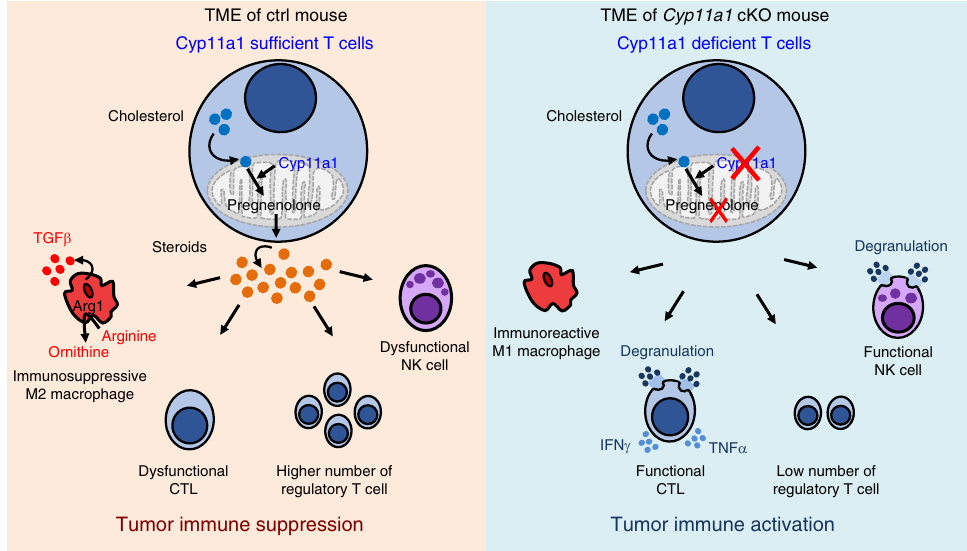
Fig. 7 Graphical abstract of the discovery. T cell-mediated de novo steroidogenesis in the tumor microenvironment promotes tumor growth by inhibiting anti-tumor immunity, in part by inducing M2 phenotype in macrophages and suppressing T and NK cell function. Genetic deletion of Cyp11a1 or pharmacologic inhibition of Cyp11a1 activity stimulates anti-tumor immunity by increasing the number of M1 macrophages and functional T cells, and decreasing the number of regulatory T cells, M2